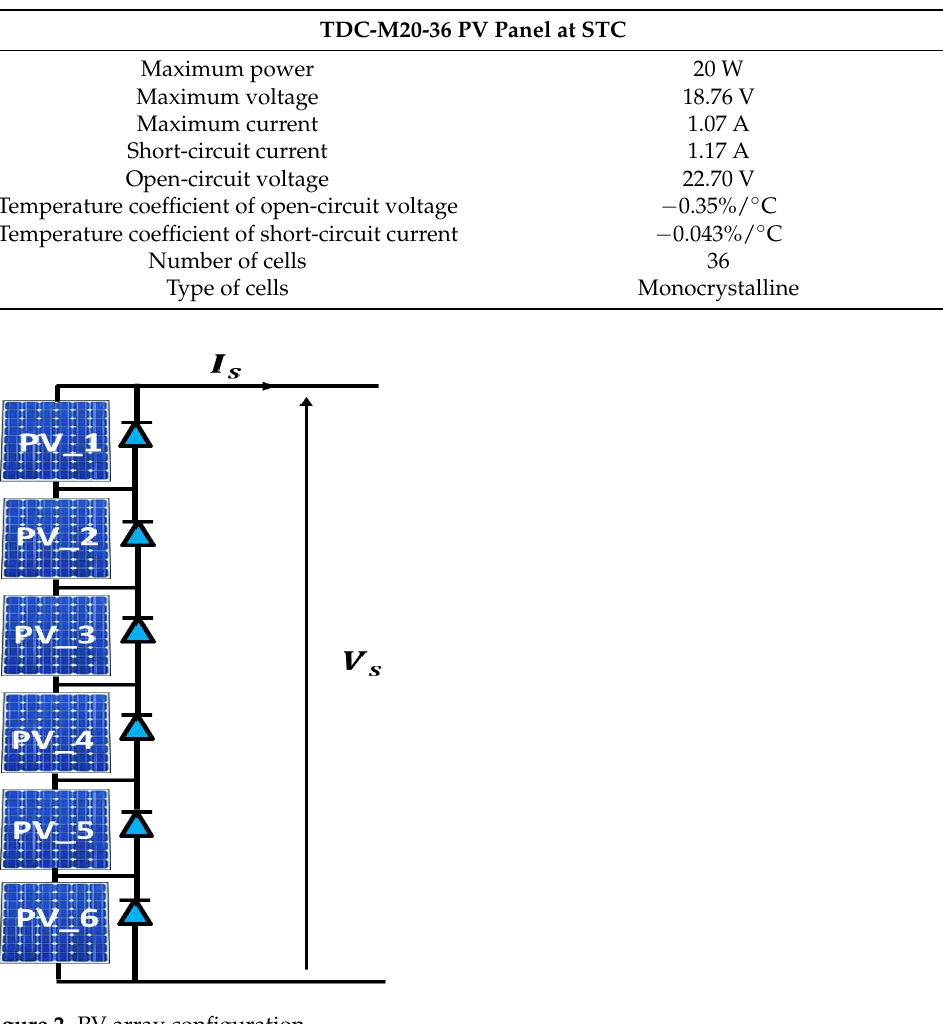
Figure 1. PV cell equivalent circuit. Table 1. Specifications of the PV panel used [30].